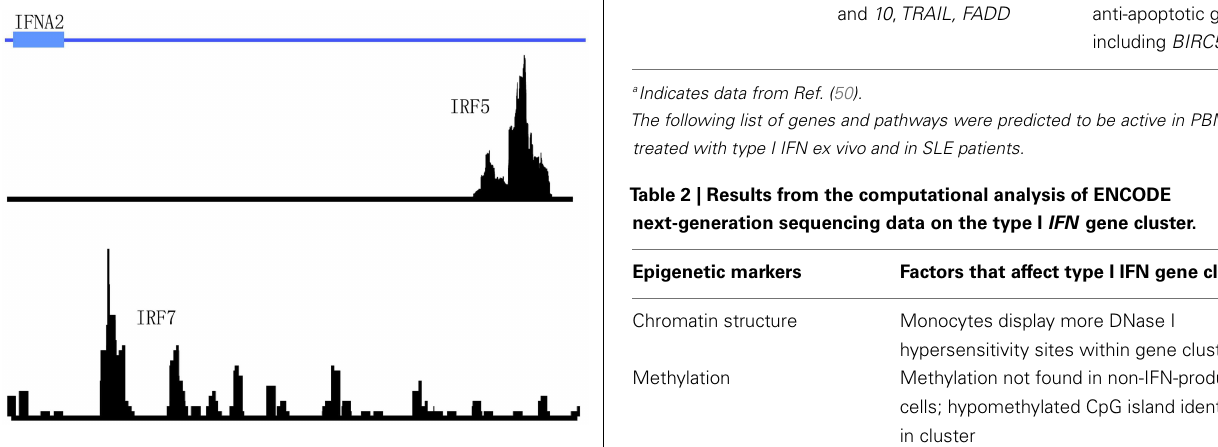
FIGURE 5 | Differential binding of IRF5 and IRF7 to the IFNA2 gene in human primary PDCs stimulated with virus .The genomic region of IFNA2 is shown with IRF5 and IRF7 ChIP-seq peaks plotted according to their enrichment positions. Briefly, human primary PDCs were stimulated with Herpes simplex virus (HSV) for 4h and cells cross-linked and harvested for immunoprecipitations with anti-IRF5 or anti-IRF7 antibodies.